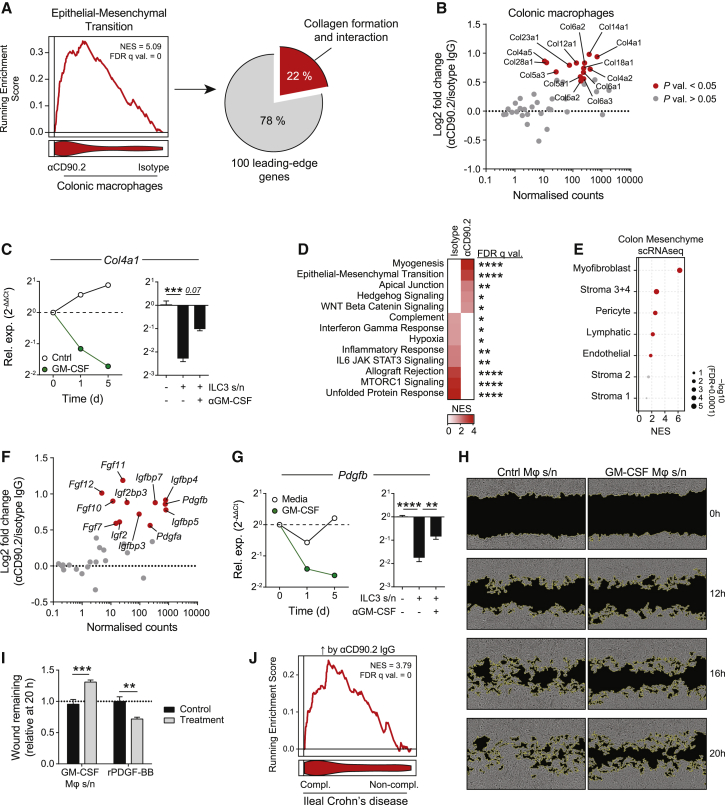
ILCs Suppress a Pro-repair Macrophage Phenotype(A) GSEA of hallmarks epithelial-mesenchymal transition pathway in colonic Ly6Clo MHC-II+ MNPs from Rag2−/− mice treated with 2% DSS ± isotype or anti-CD90.2 IgG for 6 days, with percentage of leading-edge genes involved in collagen formation/interaction shown. n = 6 per group.(B) Expression of collagen subunits in colonic MNPs in (A).(C) Col4a1 expression by BMDMs primed with GM-CSF or control media (left) or with ILC3-conditioned media ± anti-GM-CSF IgG for 16 h (right). Mean ± SEM indicated from triplicates.(D and E) RNA-seq GSEA of hallmarks pathways (D) and murine colonic stromal cell signatures (E), derived from murine DSS scRNA-seq dataset GEO: GSE114374, in whole colonic tissue of mice treated as in (A). n = 5 per group.(F) Growth factor expression in colonic MNPs as in (A). Red dots = p value <0.05.(G) Pdgfb expression in BMDMs treated as in (C). Mean ± SEM indicated from triplicates.(H and I) Scratch wound assay of murine fibroblasts cultured in conditioned medium from GM-CSF-primed or control BMDMs, or treated with recombinant murine PDGF-BB or control. Mean ± SEM indicated from 5 measurements.(J) GSEA of the top 200 upregulated genes in colonic Ly6Clo MHC-II+ following anti-CD90.2 IgG administration in mucosal biopsies of complicated (n = 27) versus non-complicated (n = 183) ileal Crohn’s disease, derived from GEO: GSE93624.Data are representative of two (H and I) or three (C and G) independent experiments. p values were calculated using standard DESeq 2 method (RNA-seq) or limma (microarray) with multiple comparisons correction using the BH correction (B and F), one-way ANOVA with Tukey’s multiple comparisons test (C and G), and multiple t tests with Holm-Sidak’s multiple comparisons test (I). ∗p < 0.05; ∗∗p < 0.01; ∗∗∗p < 0.001; ∗∗∗∗p < 0.0001. See also Figure S6.